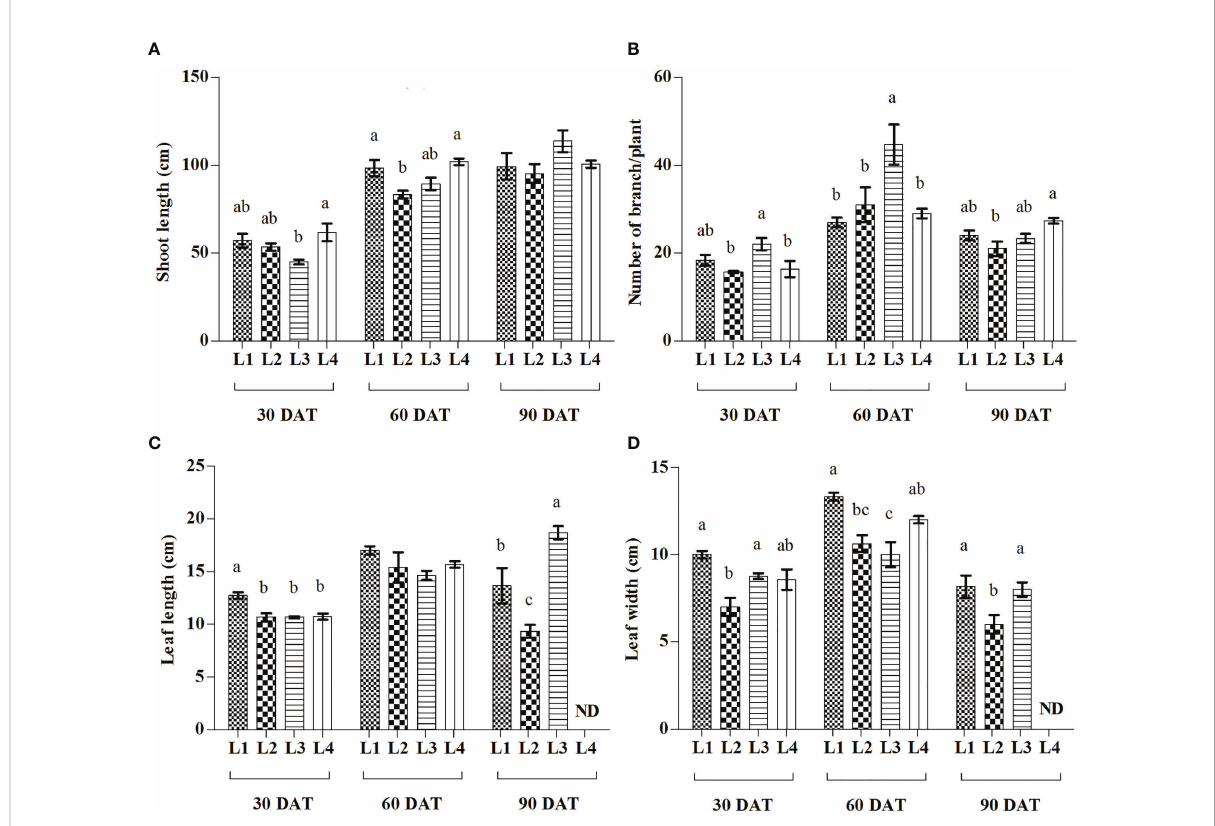
FIGURE 2 Effect of LED spectra on the shoot length (A) , number of branch (B) , leaf length (C) , and leaf width (D) of hemp seedlings at 30, 60, and 90 DAT. Here and subsequent fi gures: L1, MW 240 (Red 35% + Blue 25% + Green 40%); L2, FS 240-UV (Red 40% + UVA and Blue 26% + Green 29% + Far red 5%); L3, MB 240 (Red 85% + Blue 15%); L4, PF 240 (Red 70% + Blue 30%); ND, not detected. All treatments used a photosynthetic photon fl ux density of 300 µmol m − 2 s − 1 . Column height indicates the mean, vertical bars indicate the standard error of the mean (n = 4), and different letters indicate signi fi cant differences at p <